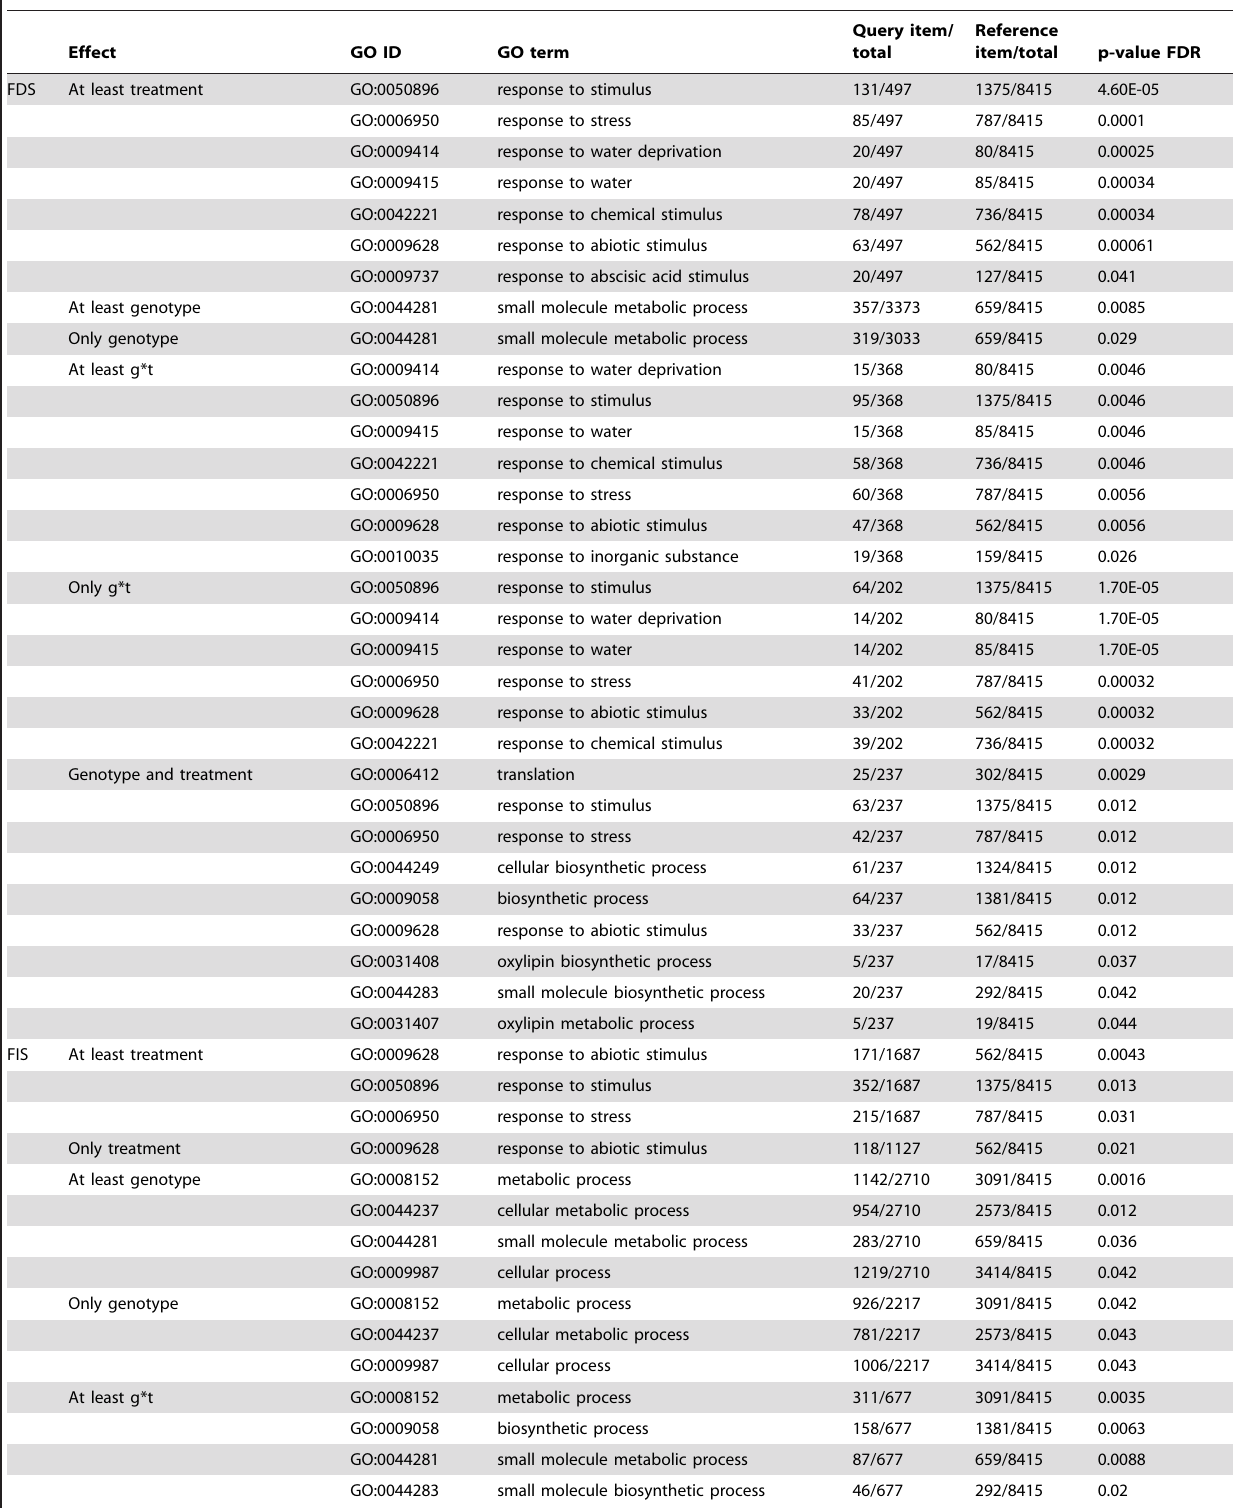
Table 2. GO term enrichment test results for genes showing ANOVA effects for two drought scenarios.